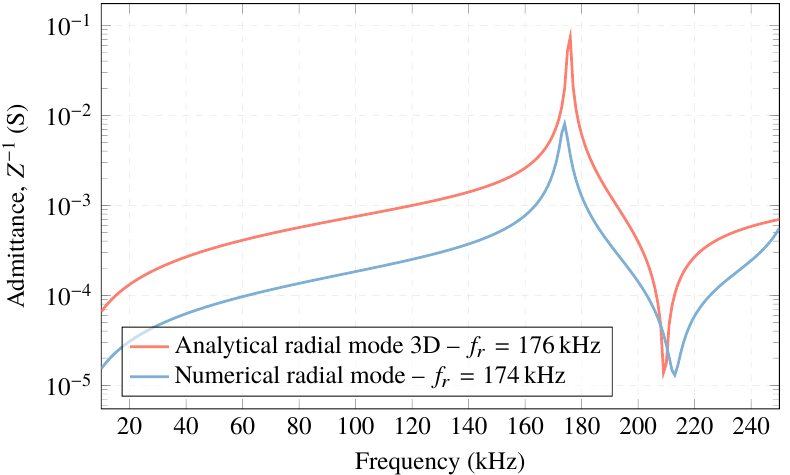
Figure 3. Electrical admittance of the analytical and numerical models for PIC 255 ceramic, R = 5mm and h = 5mm.